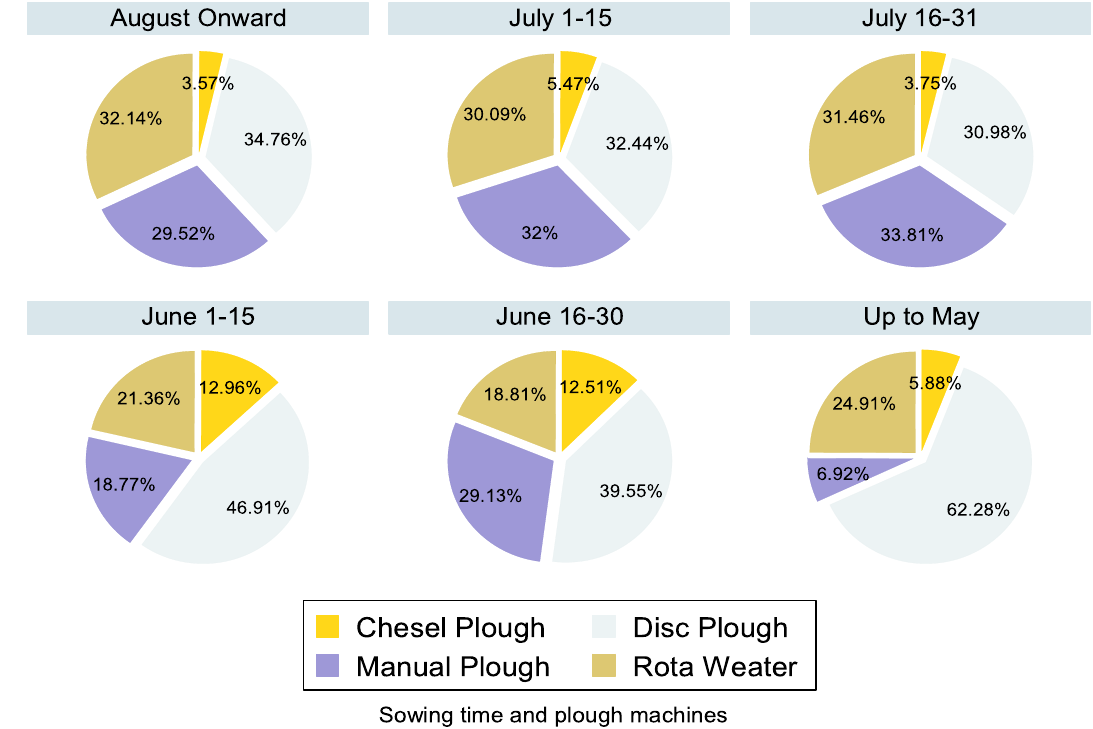
Figure 2. Sowing time and plough machines used for rice